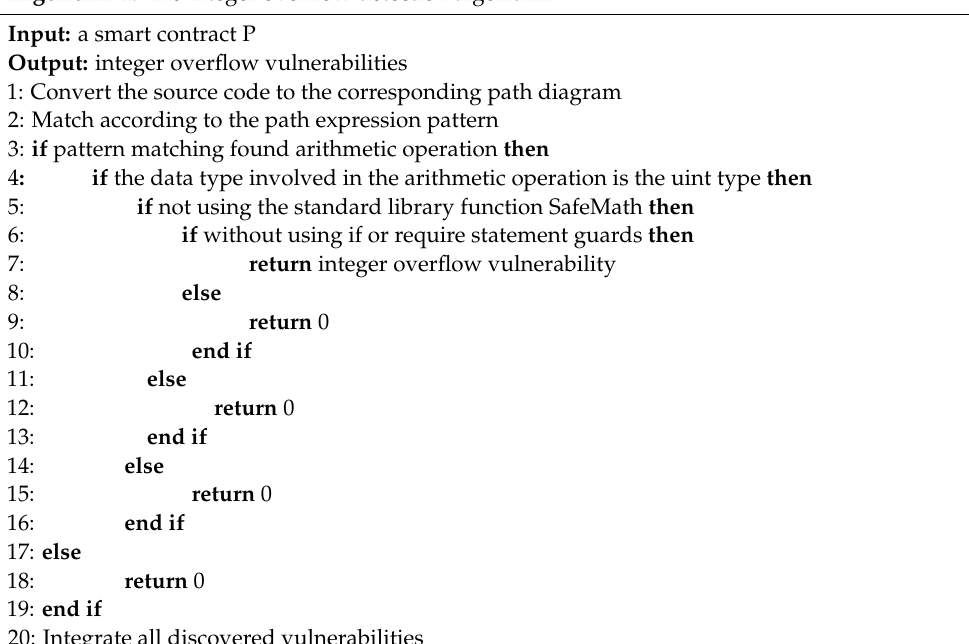
Algorithm 1: The integer overflow detection